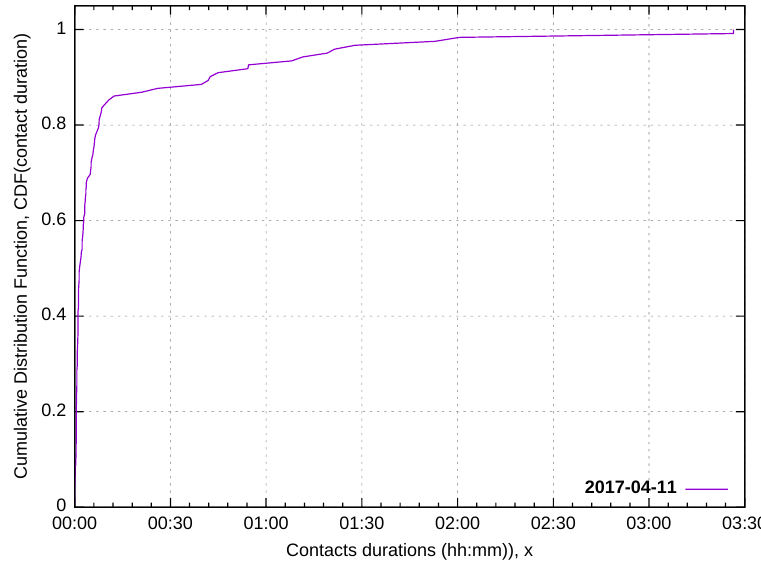
Figure 9. Cumulative distribution of contacts durations on Day